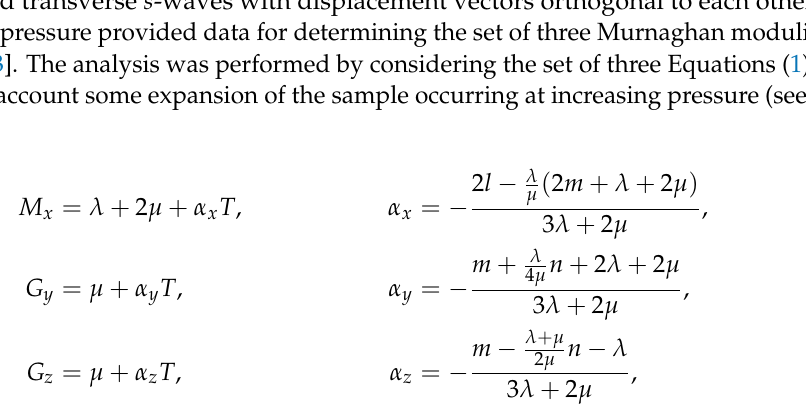
Figure 2. Experimental setup for measurements of ultrasound velocity as a function of applied stress. The dependencies of velocities of the three types of ultrasonic waves: longitudinal p -waves and transverse s -waves with displacement vectors orthogonal to each other,